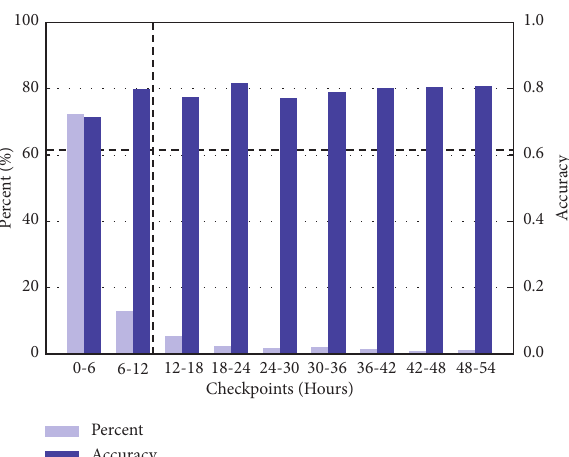
Figure 6: Proportion of Twitter events classified and detection accuracy by DDR over time. Vertical dashed line indicates the optimal checkpoint for GRU-2 and horizontal dotted line indicates GRU-2’s